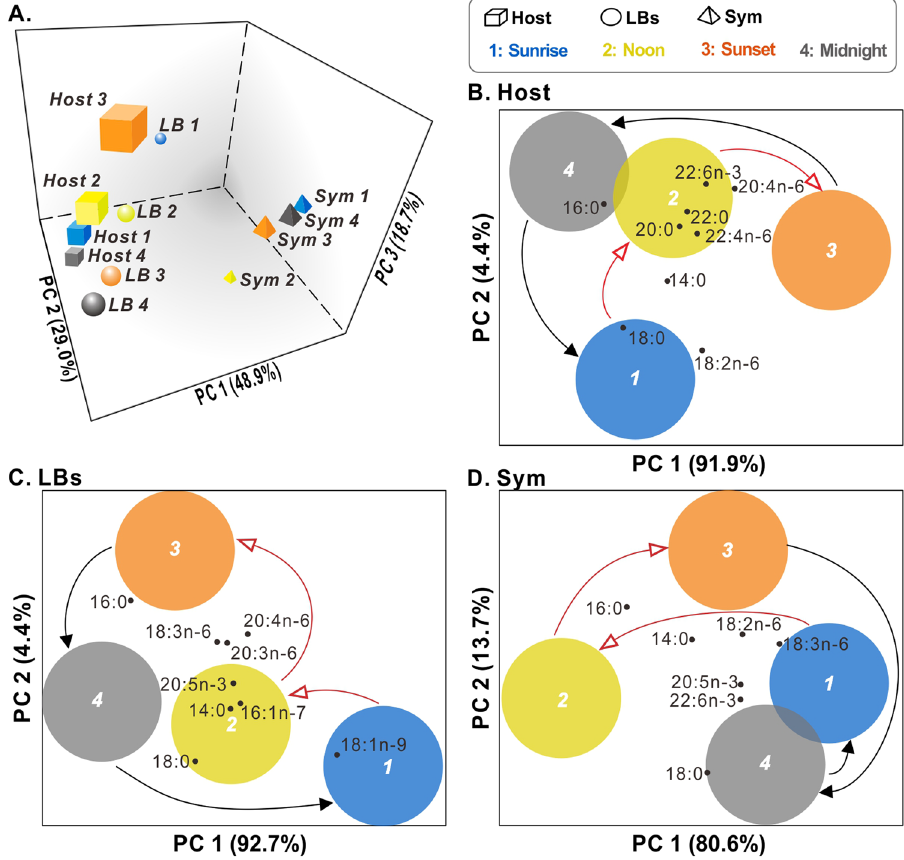
Figure 2. Dynamic change of total fatty acid pools. ( A ) Principal components analysis (PCA) of fatty acid (FA) moieties in the total lipid pools of the three cellular compartments of the Euphyllia glabrescens-Symbiodinium endosymbiosis- host coral gastrodermal cells (“Host,” cubes), lipid bodies (“LB,” spheres), and in hospite Symbiodinium (“Sym,” tetrahedrons)- across the diel cycle. The PCA bi-plots of individual compartments ( B ) host, ( C ) LB, and ( D ) Sym were included to identify the FAs that contributed most to the variation across the diel cycle. In panels (B), (C) and (D), the red arrows indicate the light period (1: sunrise [blue] and 2: noon [yellow]), and black arrows indicate the dark period (3: sunset [orange] and 4: midnight